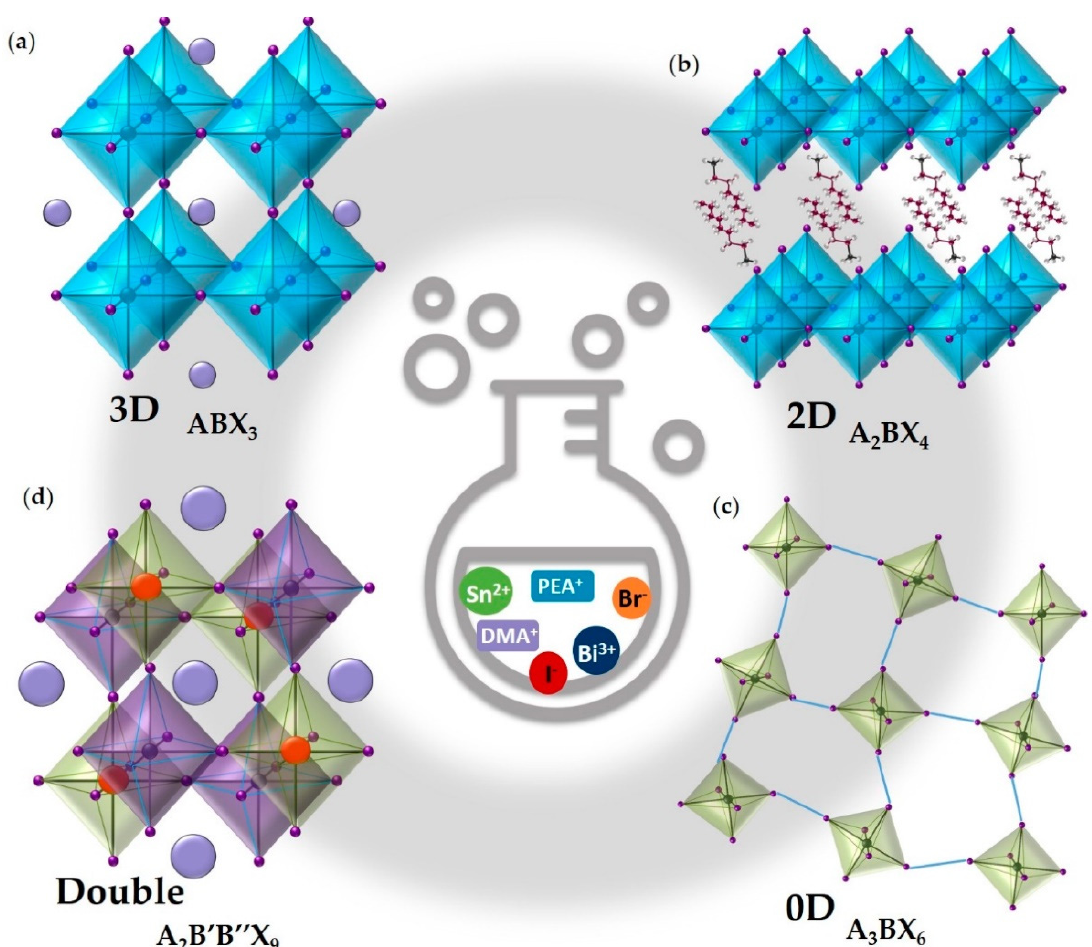
Figure 1. Listorti et al. reported complete examples of schematic crystal structures with the related chemical formula of ( a ) 3D, ( b ) 2D, ( c ) 3D, and ( d ) double metal halide perovskites used for H 2 evolution [19].